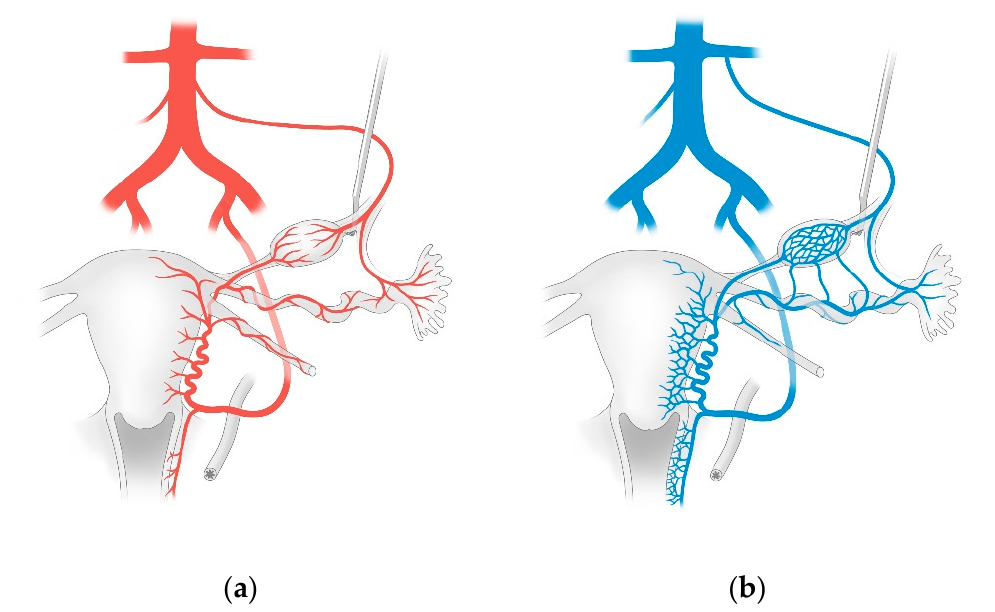
Figure 1. Blood supply: the ( a ) arterial and ( b ) venous blood supply to the female genital organs. The